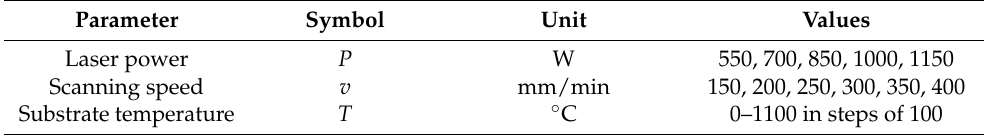
Table 2. Process conditions for the full-factorial parameter